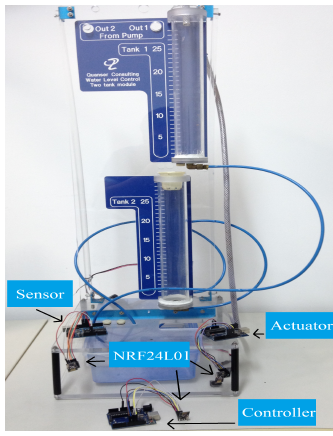
Figure 4. Benchtop developed for experimental